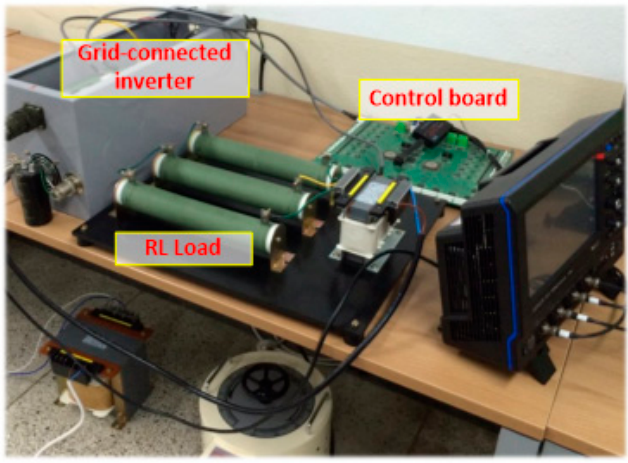
Figure 9. A picture of the experimental set-up for a single-phase grid-tied inverter system.